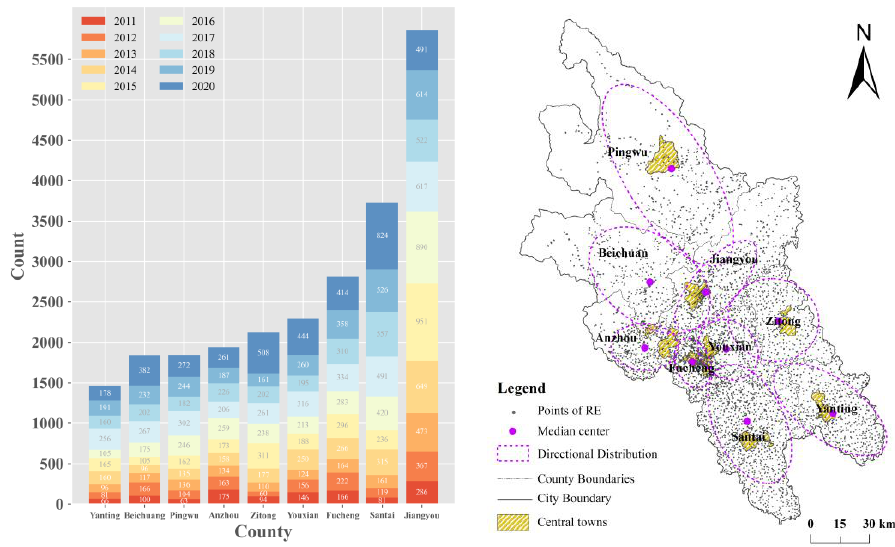
Figure 4. Annual rural entrepreneurship in the sub-administrative area of Mianyang from 2011 to 2020 ( left panel) and median center and directional distribution of rural entrepreneurship in 9 sub- administrations of Mianyang ( right panel).